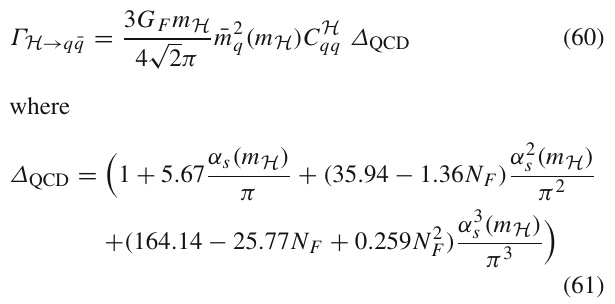
Fig. 1 The allowed region in ( λ a ,λ b ) for two values of δ T = 5 , 10. Color codes are as follows, orange: excluded by Unitarity constraints. Red: excluded by Unitarity & BFB constraints. Blue: excluded by Unitarity & BFB & VC constraints. The green area represents the